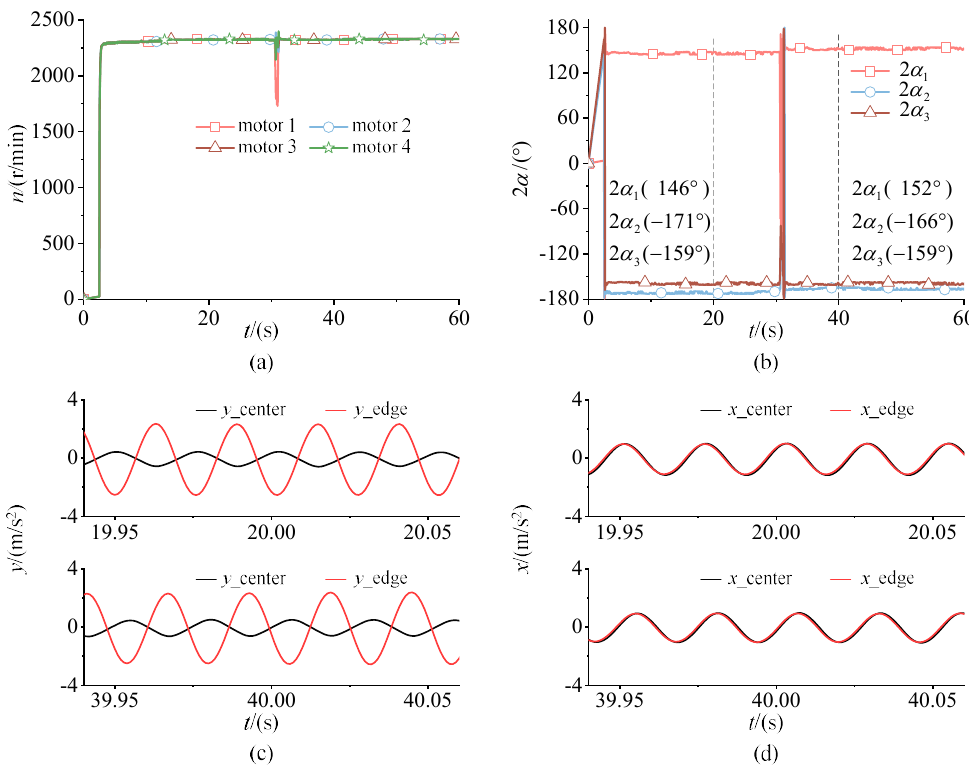
Figure 10. Phase differences of ERs change from 180 ◦ to 180 ◦ with disturbance: ( a ) Synchronous velocities of four ERs; ( b ) Phase differences; ( c ) Acceleration amplitude in y direction at 20 s and 40 s; ( d ) Acceleration amplitude in x direction at 20 s and 40 s.